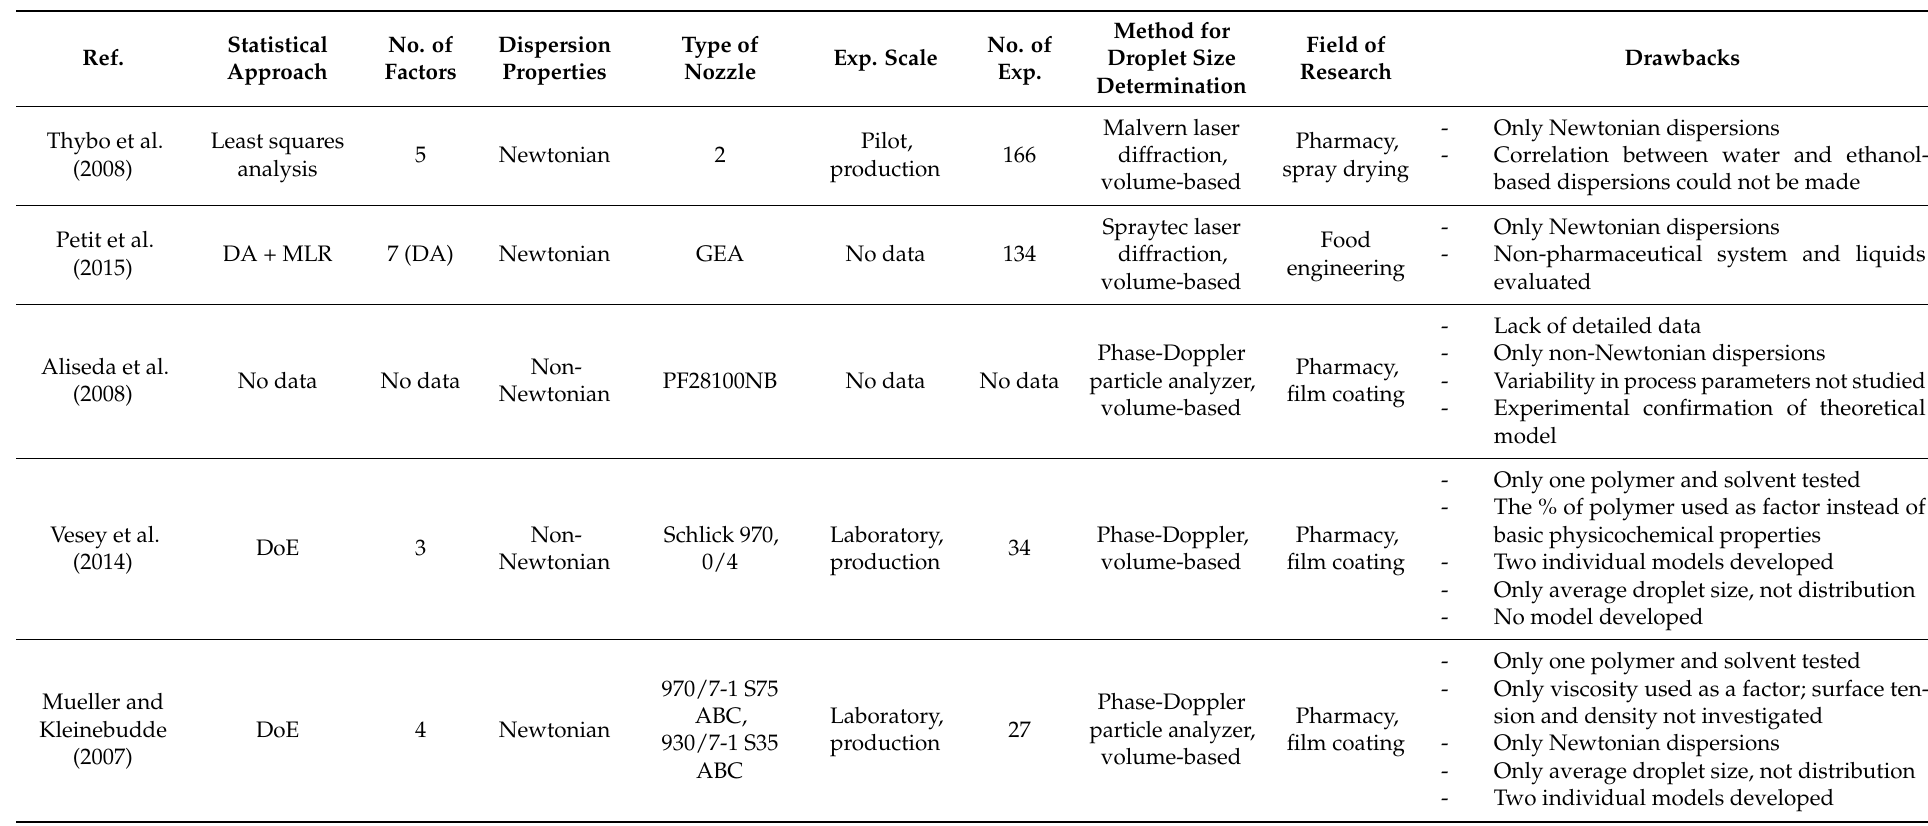
Table 1. Outline of published semi-empirical model characteristics. DA = dimensional analysis, MLR = multilinear regression, DoE = design of experiments, ANOVA = analysis of variance, and PCA = principal component